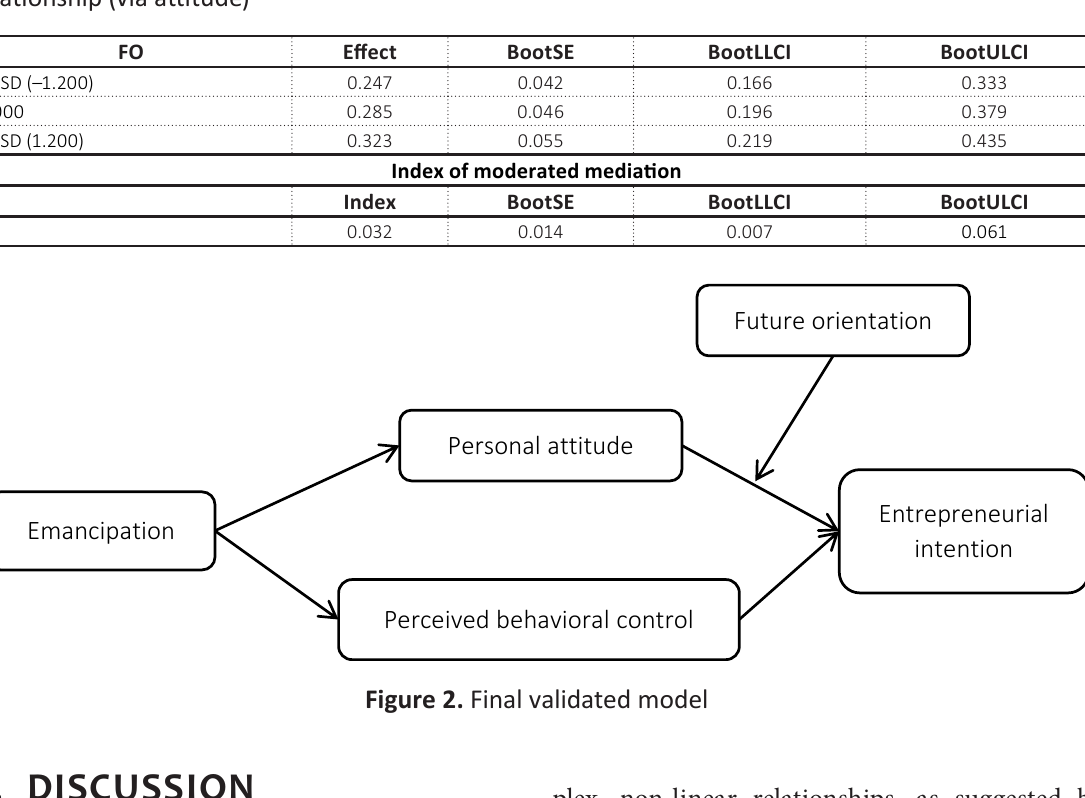
Personal Perceived behavioral control Figure 2. Final validated model